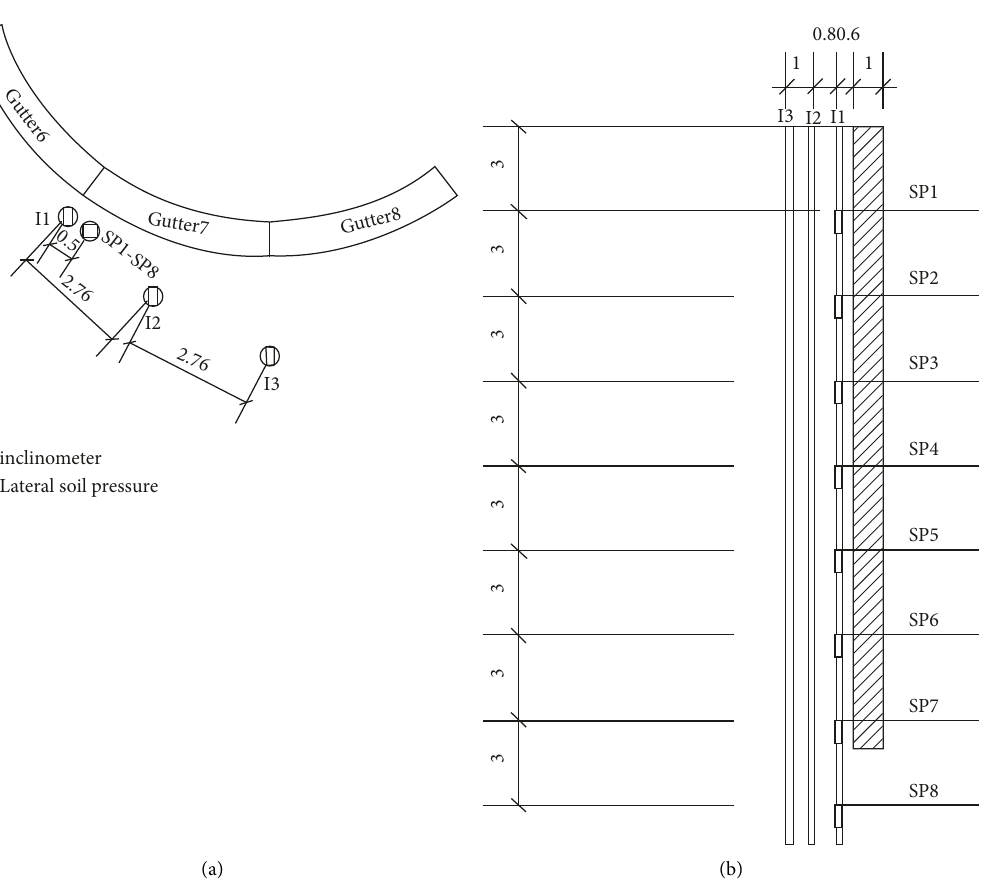
Figure 23: Monitoring stations. (a) Plane layout. (b) Monitoring